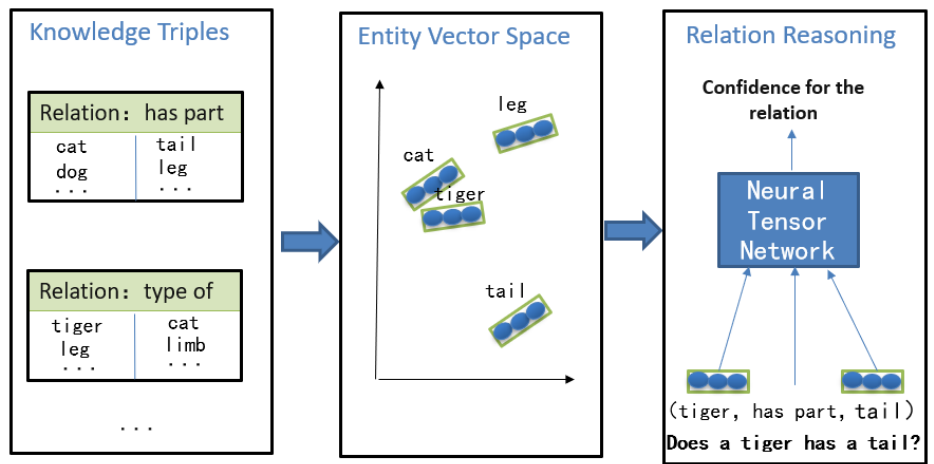
Figure 8. A simple example that uses the NTN method to predict new relationships. R-GCN [34] is different from conventional GCNs in that it introduces a relational transformation determined by the type and direction of the edge (Figure 9), and the last term of + represents the self-connection of the node. The red part represents the entity. Matrix operation is performed with the blue neighbor node, and then the edge type of each relationship is converted to obtain the normalized result and sum of the green part. After summation, the result is transmitted through an activation function, and the node parameters of the model are updated.